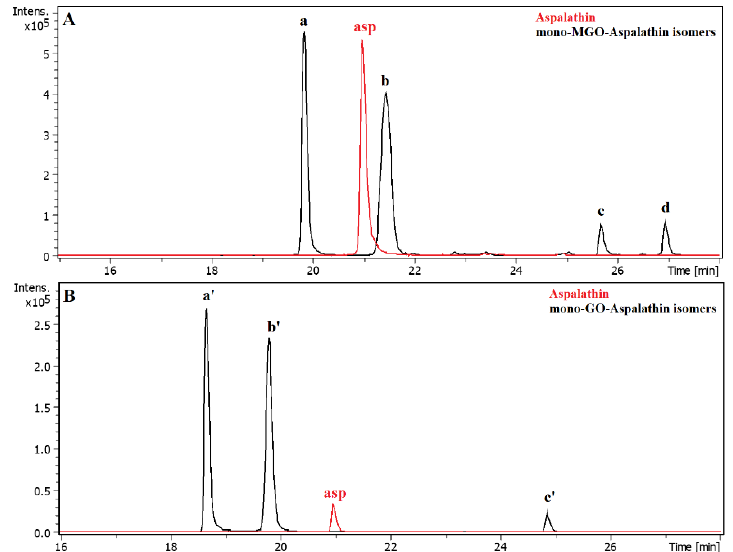
Figure 5. Representative LC chromatograms of aspalathin and its methylglyoxal ( A )/glyoxal ( B ) adducts after 1 h of incubation in pH 7.4 phosphate buffer solution at 37 ◦ C; ( A ), mono-MGO-aspalathin; ( B ) mono-GO-aspalathin; a, mono-MGO-aspalathin a; b, mono-MGO-aspalathin b; c, mono-MGO-aspalathin c; d, mono-MGO-aspalathin d; a’, mono-GO-aspalathin a; b’, mono-GO-aspalathin b; c’, mono-GO-aspalathin c; asp, aspalathin.